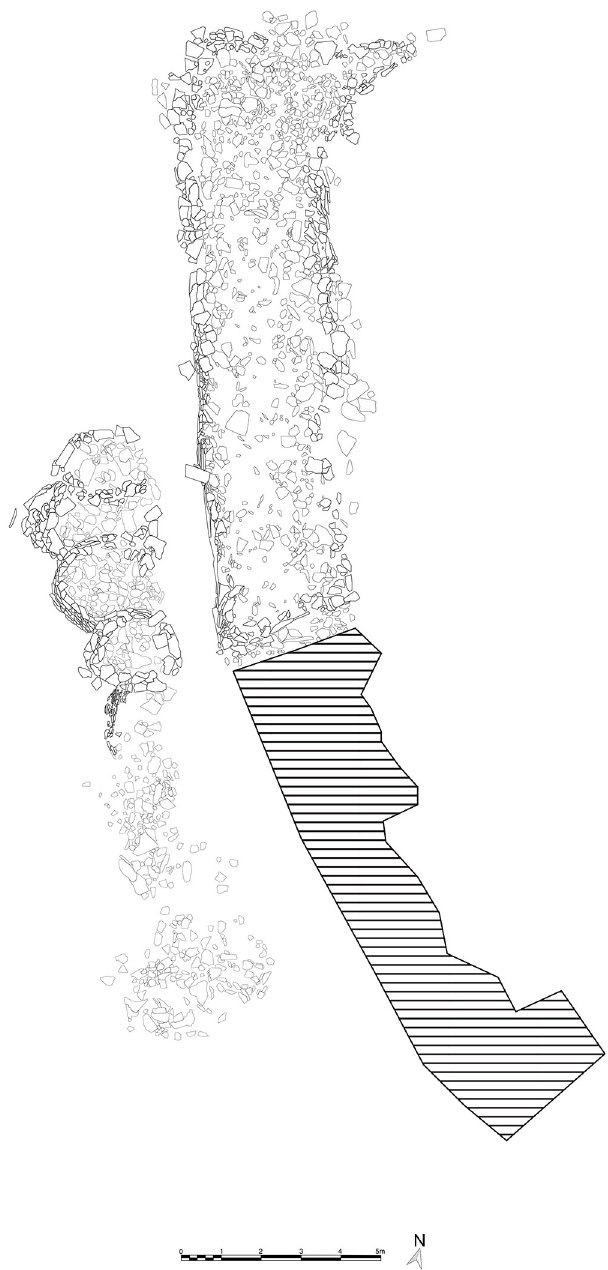
Fig 4. Plan of the base of mustatil IDIHA-F-0011081 and associated feature IDIHA-F-0011149. Hatching indicates unexcavated